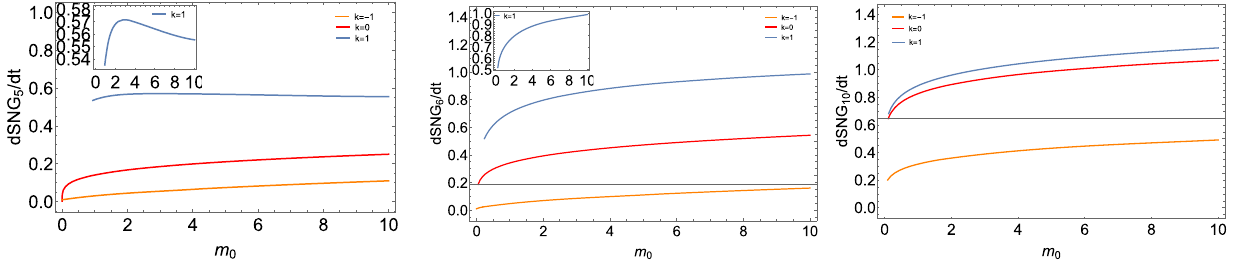
Fig. 6 Action growth v.s. black hole mass from left to right, the dimension is 5 , 6 and 10. In all cases, we have set the m = 0 ,v = 0 .